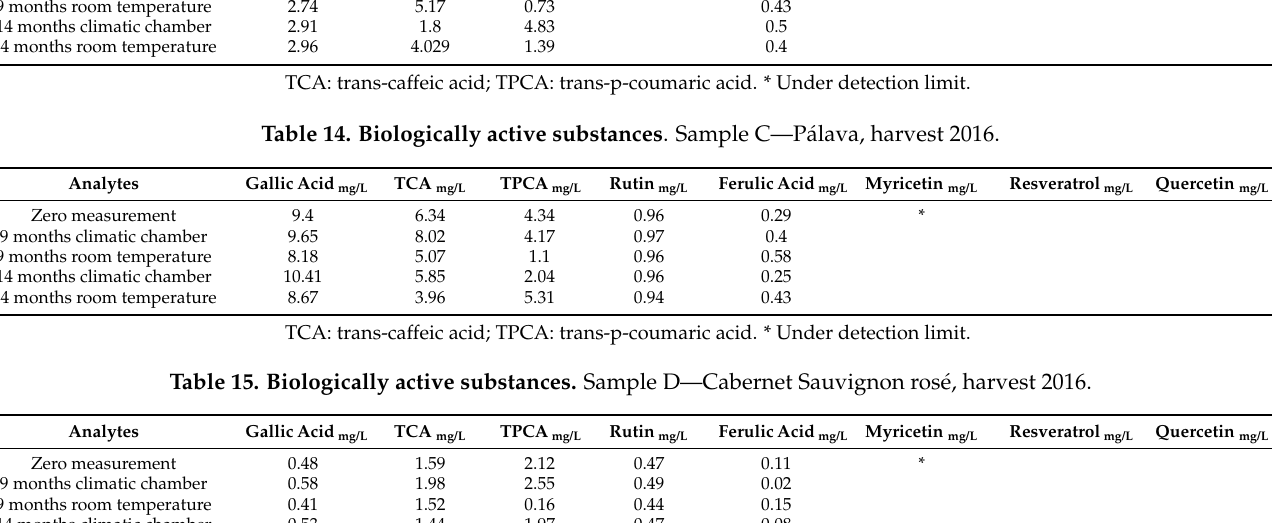
Table 13. Biologically active substances . Sample B—Chardonnay, harvest 2016. Analytes GallicAcid mg/L Zero measurement